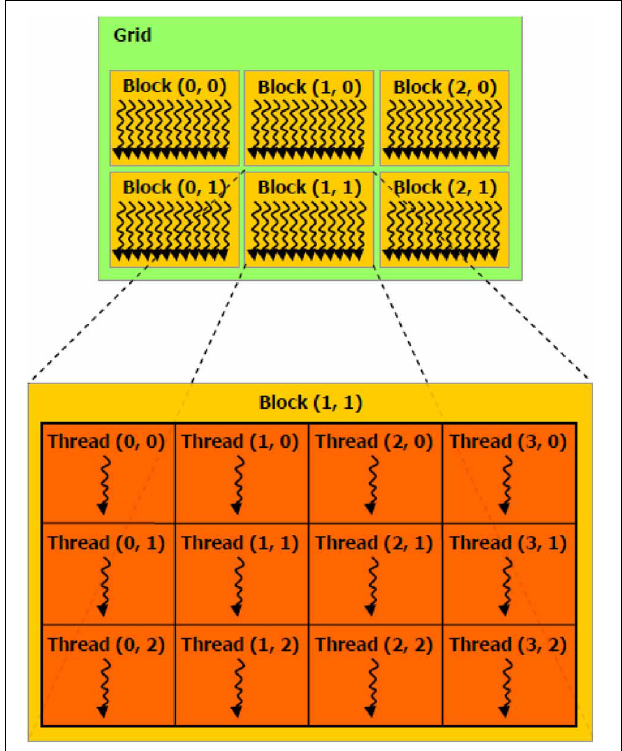
FIGURE 2 | Parallel execution work-items on a GPU.